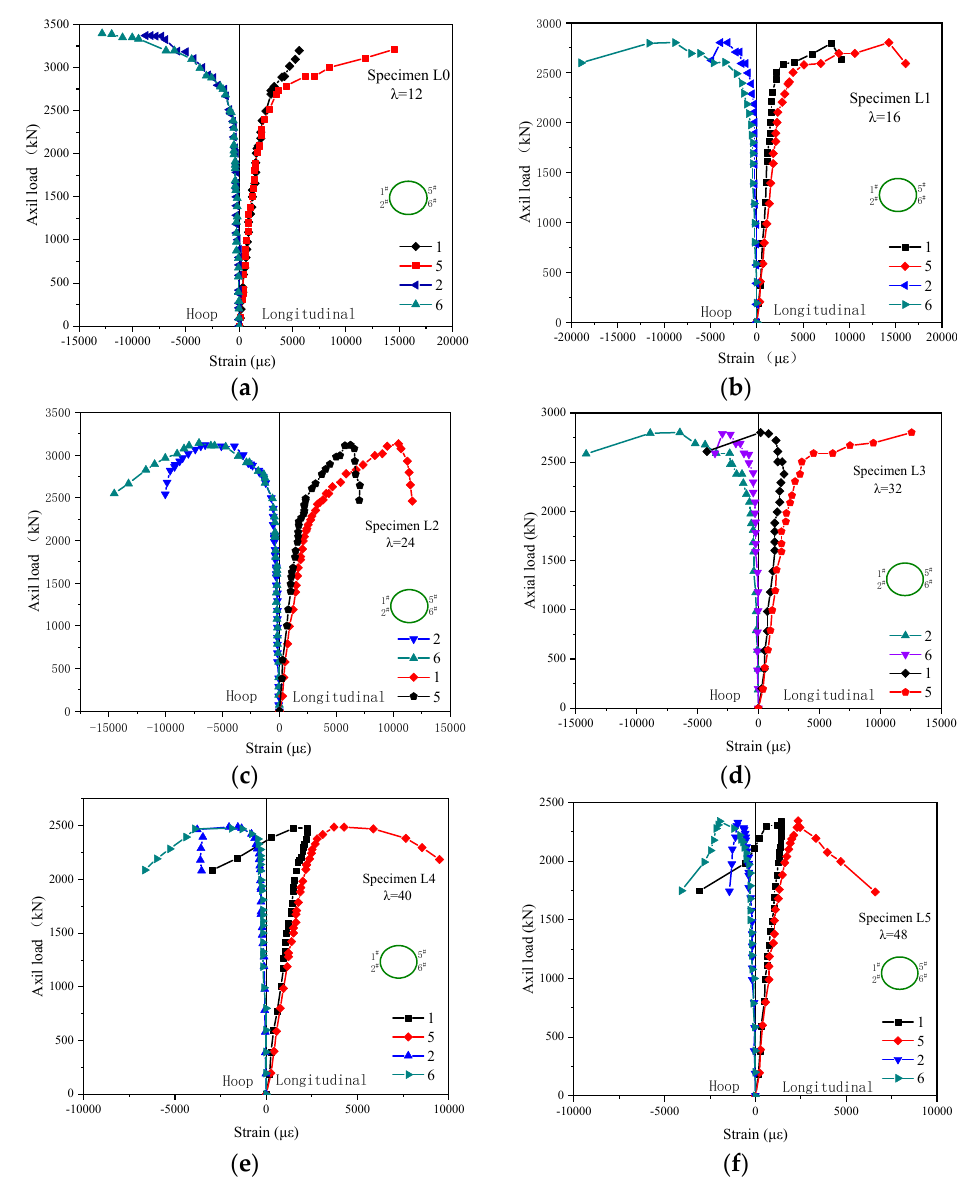
Figure 6. The relationship between the GFRP tube strain and axial load: ( a ) L0; ( b )L1; ( c ) L2; ( d ) L3; ( e ) L4; ( f ) L5.